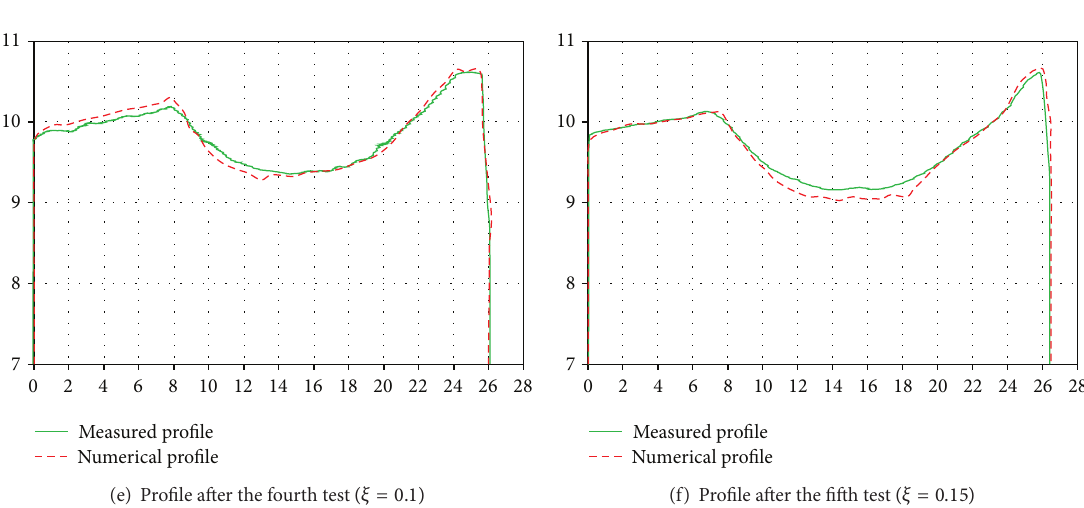
(f) Profile after the fifth test (𝜉 = 0.15) Figure 9: Shape of the wheel profile after the tests (units in mm): comparison of the measured and the numerical results (all the tests are performed with a reference speed of 500 rpm except the last one, performed at 250